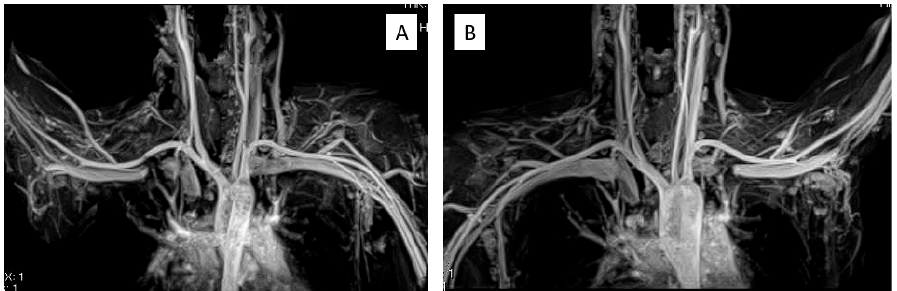
Figure 1. MRI-MIP display from the chest to the upper arm. ( A ) Raised right arm. ( B ) Raised left arm. MRI-MIP, magnetic resonance imaging maximum-intensity projection.